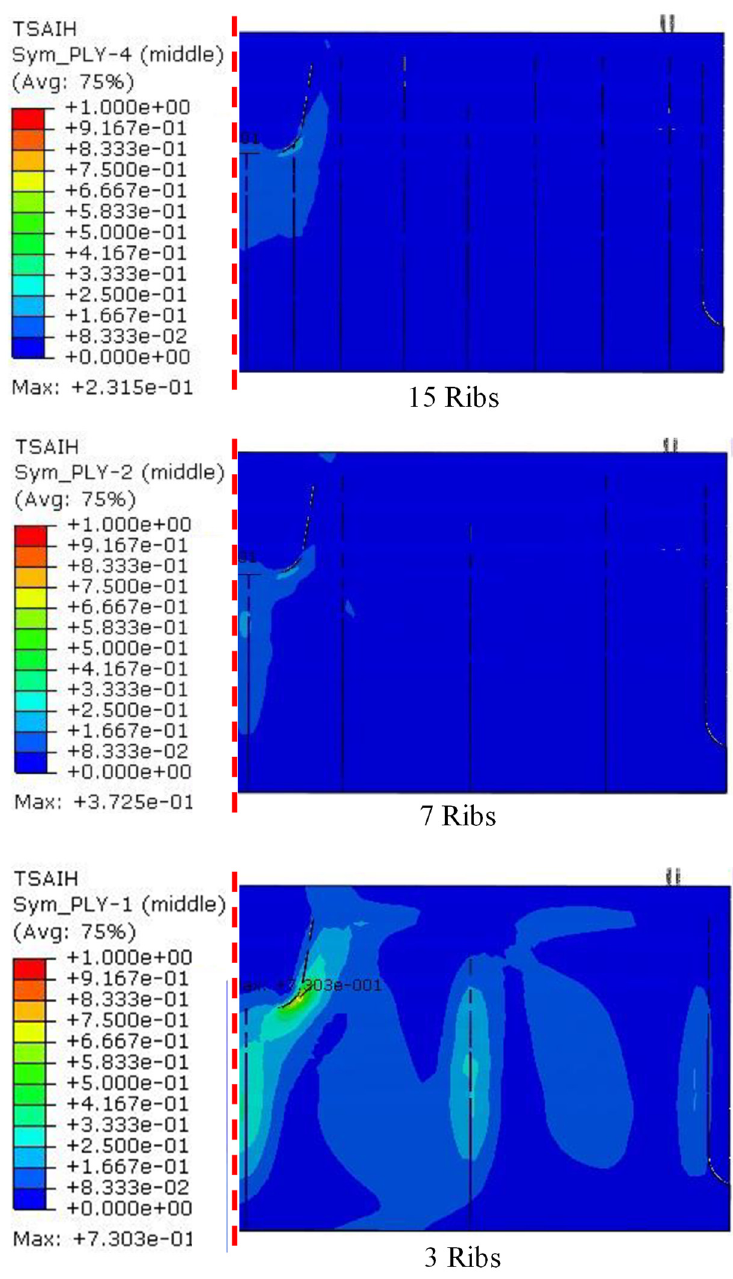
Figure 7. The Tsai–Hill failure index for multi-rib configurations (half-model presented).